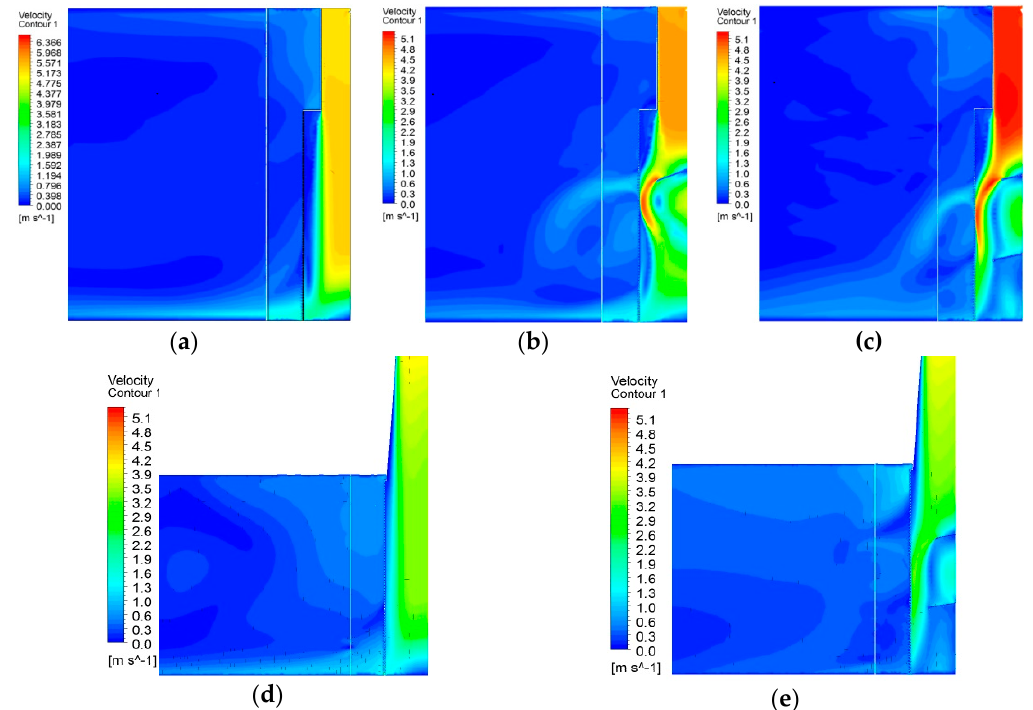
Figure 3. Velocity distribution in the premises with the air distribution system.